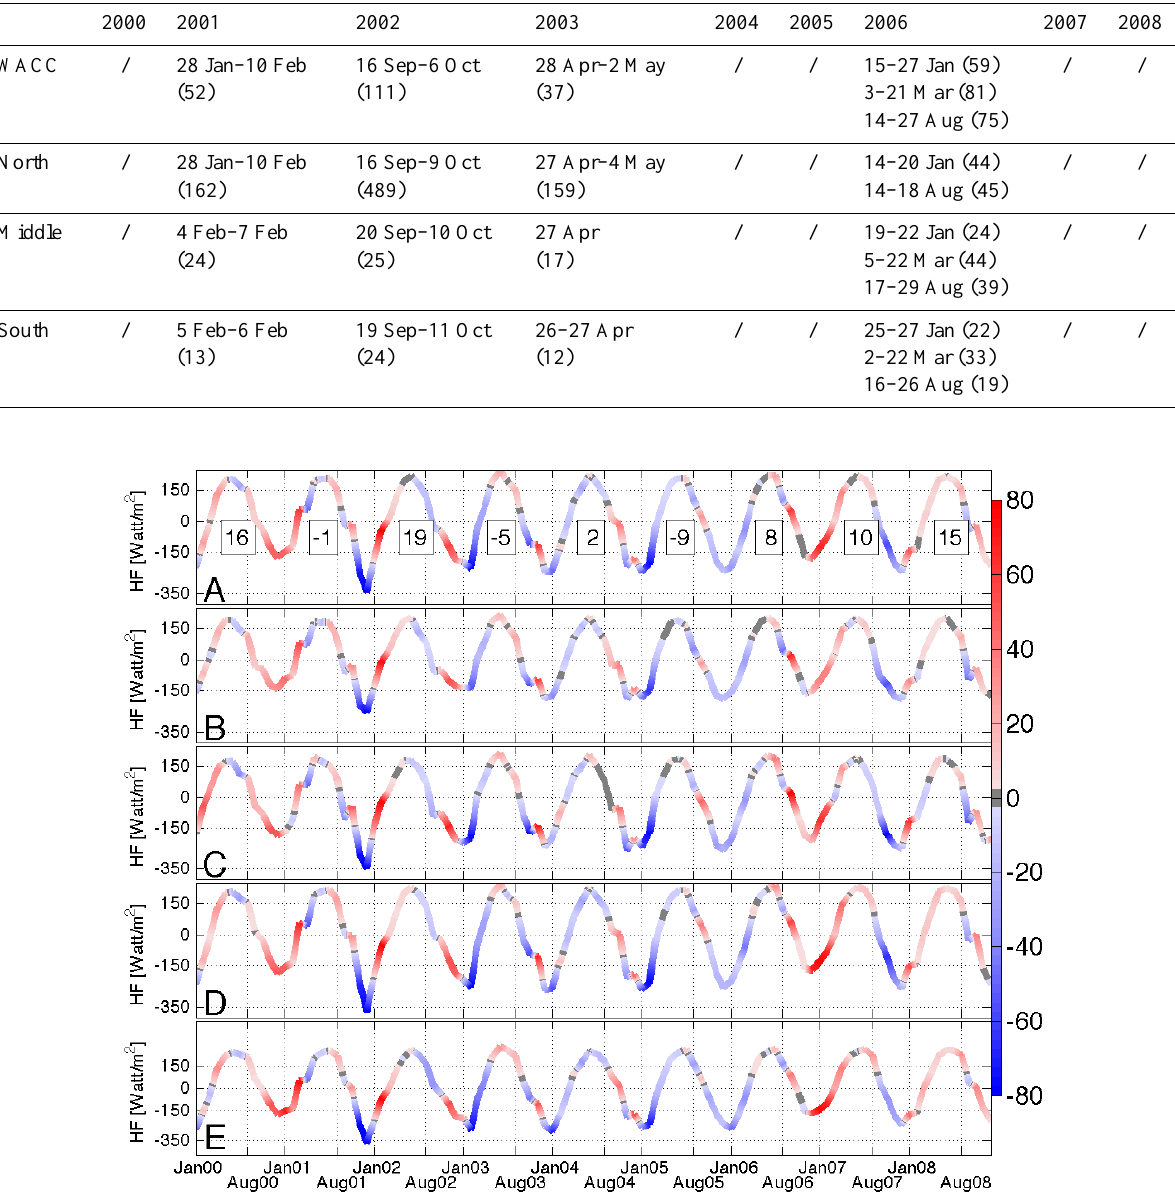
Fig. 2 Monthly time series of total Heat Flux, units are W/m 2 . Colour indicates monthly anomaly Fig. 2. Monthly time series of total Heat Flux, units are Wm − 2 . Colour indicates monthly anomaly values. (A) : whole Adriatic Sea; (B) : values. A: whole Adriatic Sea; B: WACC region; C: Northern Adriatic Region; D: Middle Adriatic WACC region; (C) : Northern Adriatic Region; (D) : Middle Adriatic Region; (E) : Southern Adriatic Region; E: Southern Adriatic Region.